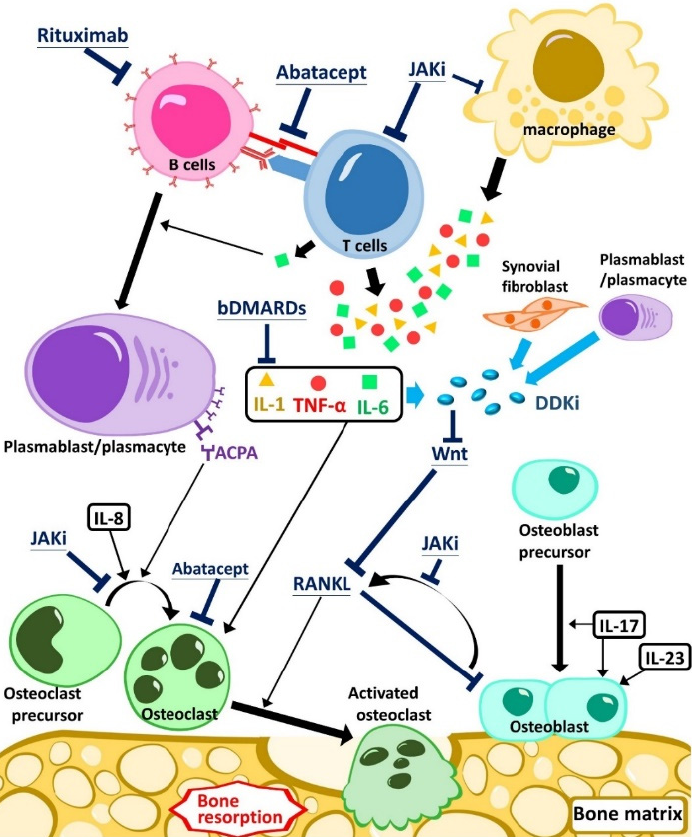
Figure 1. The mechanism of the effect of biological/targeted therapies on bone metabolism in in- flammatory arthritis. bDAMARDs, biologic disease-modifying antirheumatic drugs (DMARDs); IL, interleukin; JAKi, Janus kinase inhibitors; TNF- α , tumor necrosis factor- α .